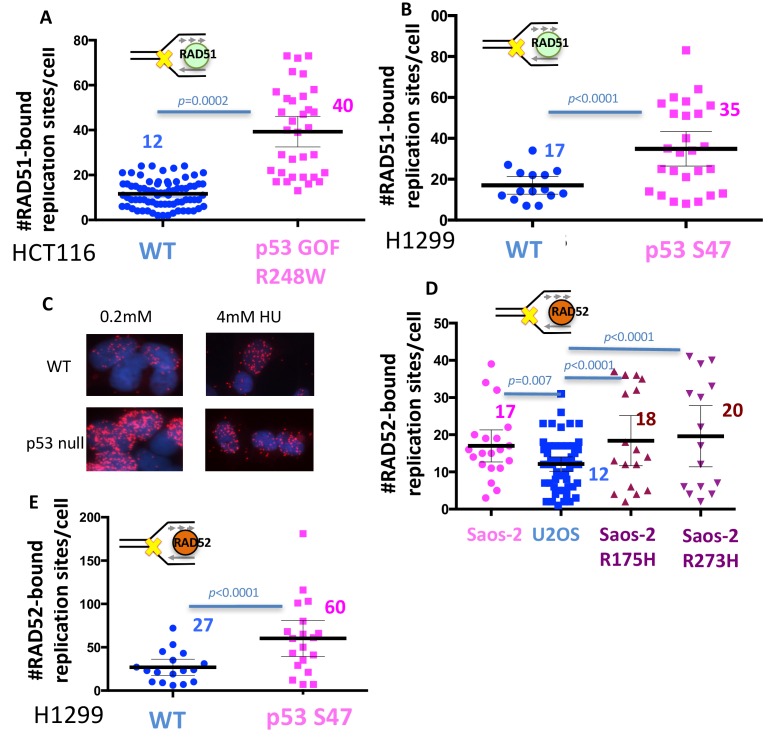
RAD52-SIRF is upregulated in mutant p53 cells.(A) Quantitation of SIRF assay of RAD51 at HU stalled replication forks in p53 R248W and WT p53 HCT116 cells. (B) Quantitation of SIRF assay of RAD51 at HU stalled replication forks in p53 S47 and WT p53 H1299 cells. (C) Representative images of SIRF assay of RAD52 in HAP-1 cells at low (0.2 mM) and high (4 mM) HU concentrations show preferential binding of RAD52 at stalled forks with low HU concentrations compared to high HU concentrations, which are more favorable for break formation. Images are representative images from Fig. 4C (D) Quantitation of SIRF assay of RAD52 at HU stalled replication forks in p53 R175H, p53 R273H and p53 null Saos-2 sarcoma cells, and WT p53 U2OS sarcoma cells. (E) Quantitation of SIRF assay of RAD52 at HU stalled replication forks in p53 S47 and WT p53 H1299 cells. Bars represent the mean and the 95% confidence interval. Significance values are derived from student T-test analysis normalized to the respective EdU-PLA intensities (Supplementary file 1).